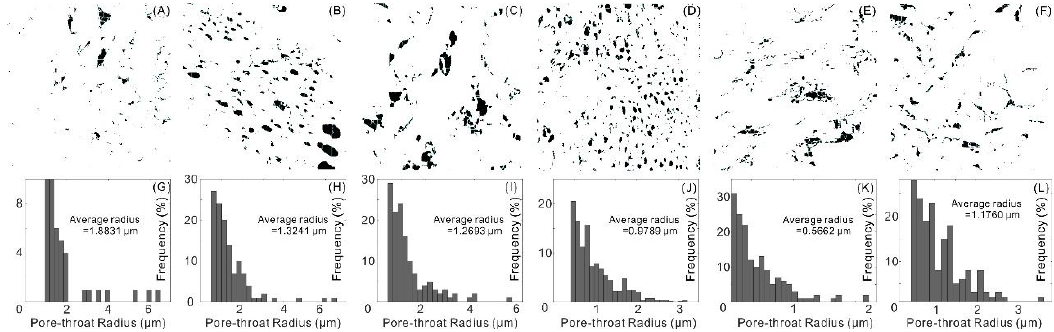
Figure 7. Visual output of the pore-throat of SEM image in Figure 1 with the blue line ( A – L ) correspond to Pore radius distribution of ( A – F ).